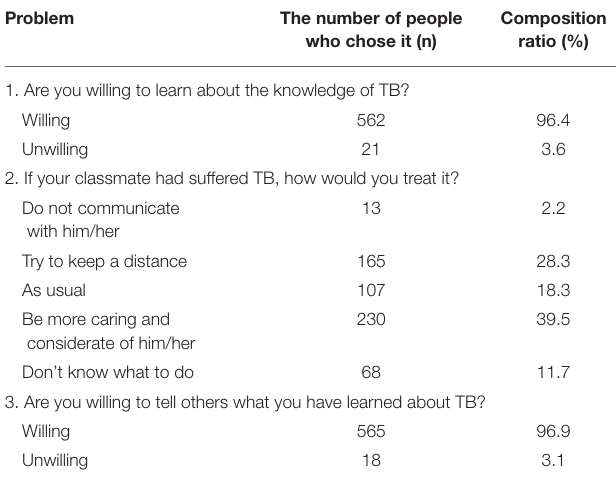
TABLE 5 | The related attitudes toward TB ( n = 583).